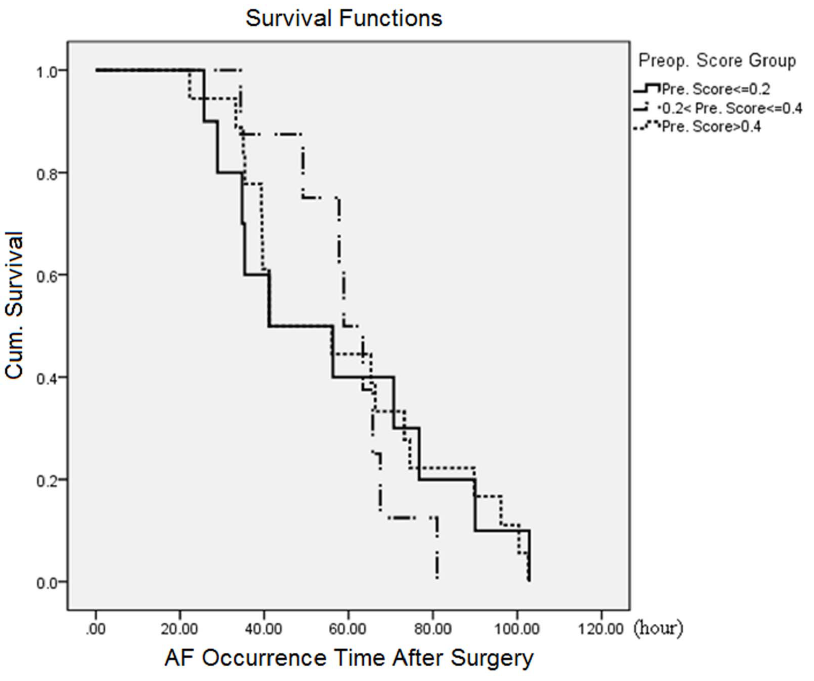
Figure 3. Survival curves as a function post-operative time of AF onset. The survival curves of three groups AF patients defined by their preoperative risk score: 1) ƒ 0.2; 2) 0.2 , P ƒ 0.4; 3) . 0.4.